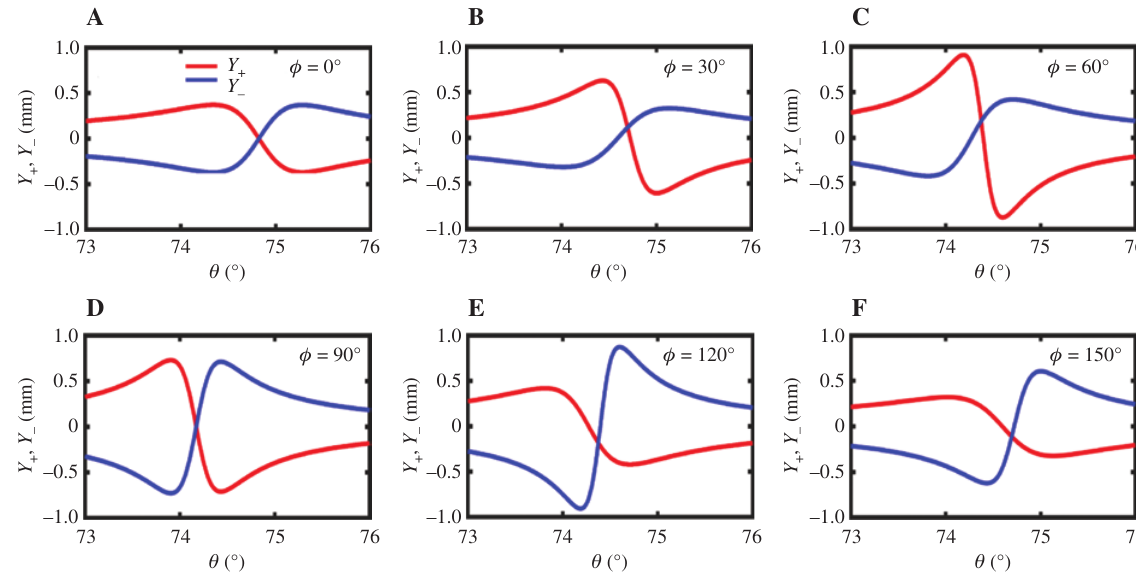
on the incident angle θ for φ = 0 ° , 30 ° , 60 ° , 90 ° , 120 ° , 150 ° , respectively. In the ±